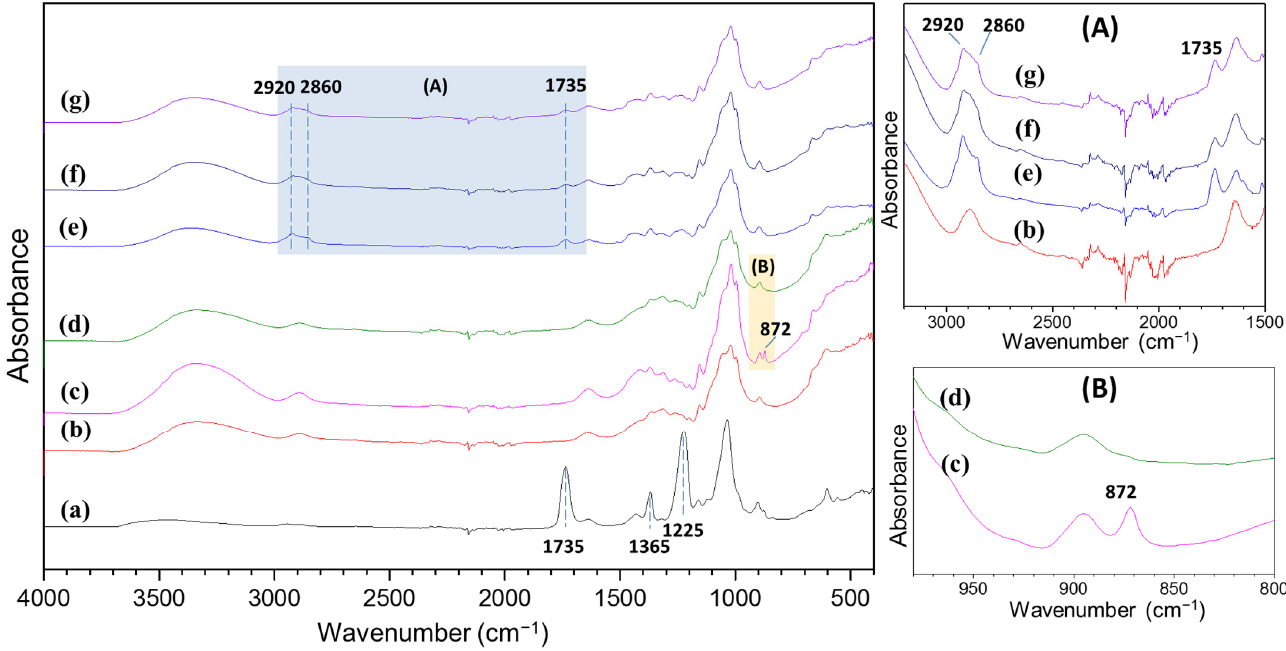
Figure 2. The FT-IR spectra of ( a ) CA, ( b ) CL, ( c ) AgNO 3 -CL, ( d ) Ag-CL, ( e ) OEO-CL, ( f ) Ag-OEO5%-CL, and ( g ) Ag-OEO10%-CL; ( A ) magnified view of FTIR spectrum of OEO; and ( B ) magnified view of FTIR spectrum of AgNO 3